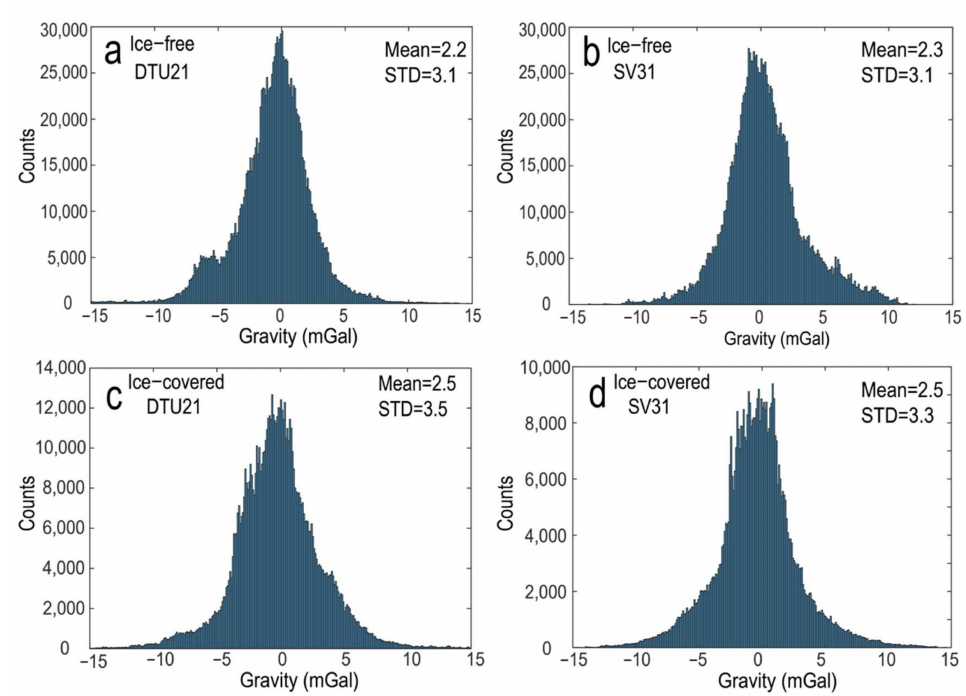
Figure 4. ( a – d ) Difference between shipborne and satellite altimetric gravity in different ice conditions.